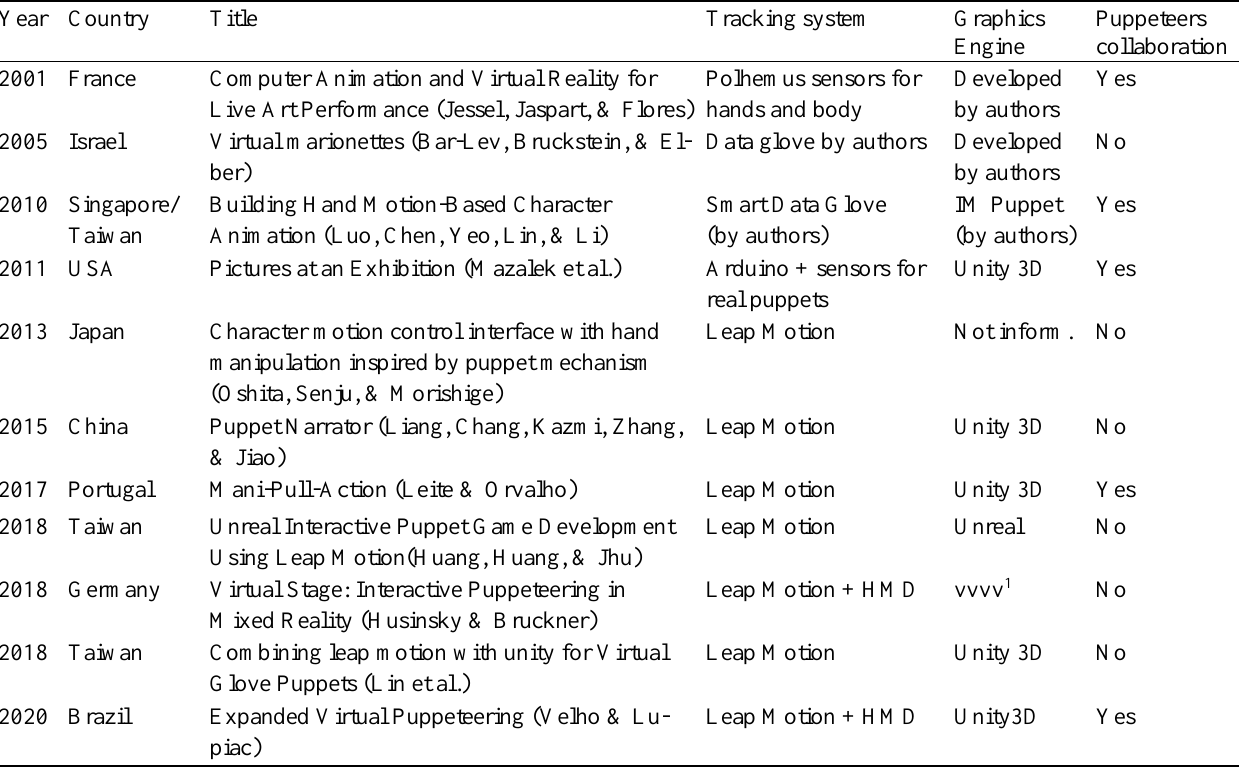
Table 1. Literature review of Virtual Reality and Augmented Reality for Puppeteering Year